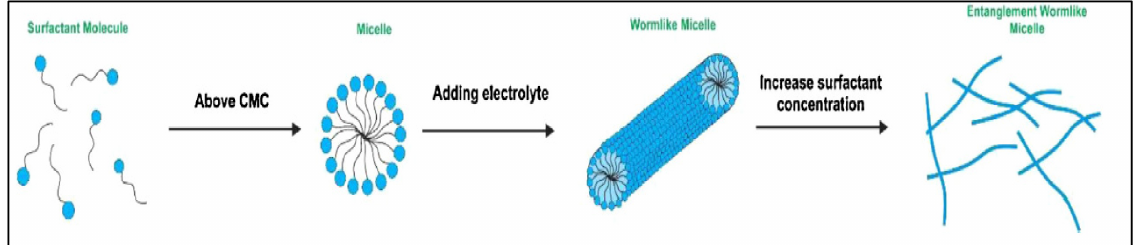
Figure 2. The transformation of conventional surfactant to worm-like micelles (Reprinted with permission from Fei et al. [39]). Copyright 2017, The Korean Society of Industrial and Engineering Chemistry. Published by Elsevier B.V.